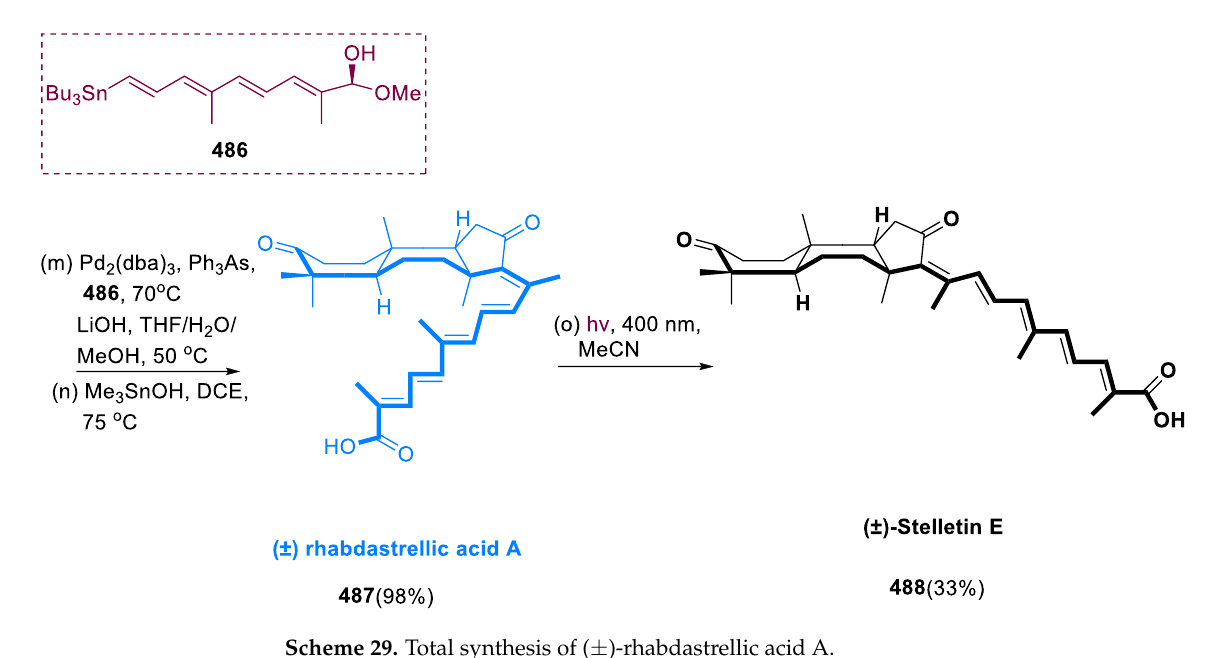
Scheme 29. Total synthesis of (±)-rhabdastrellic acid